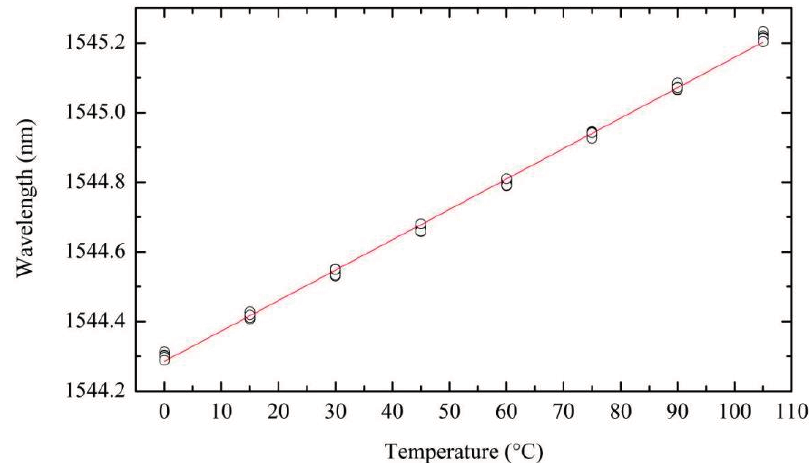
Figure 6. FBG peak wavelength as a function of temperature, the circles show the experimental data and the line is the linear fit over the measurement